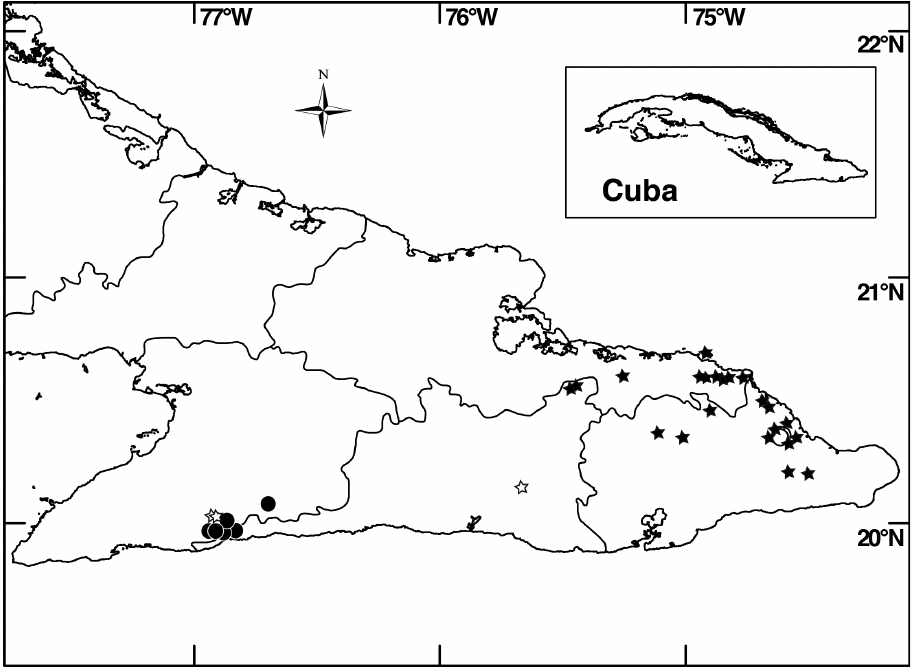
Figure 4. Distribution map of Miconia hirtistyla (closed circles), M. jashaferi (closed stars), M. cubaci- nerea (open circle), and M. tentaculicapitata (open